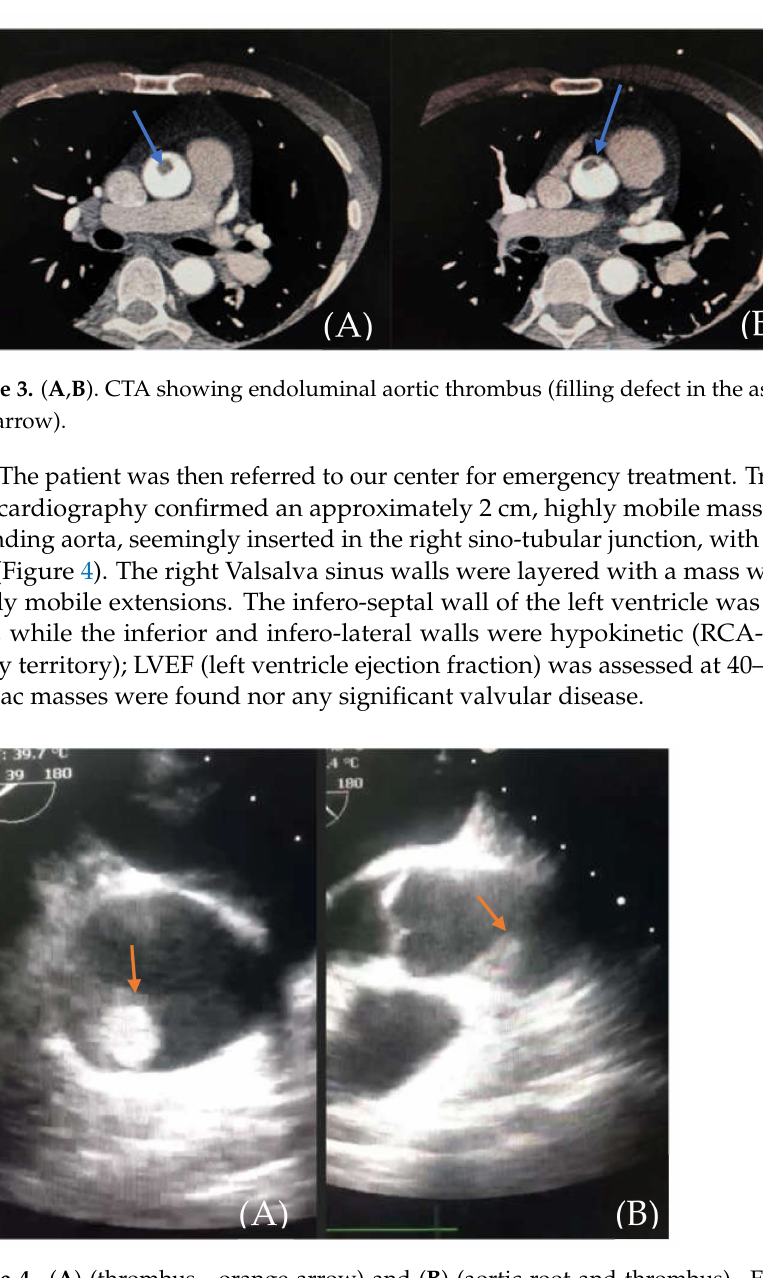
Figure 4. ( A ) (thrombus—orange arrow) and ( B ) (aortic root and thrombus). Emergency room transesophageal echocardiography showing the floating thrombus located in the ascending